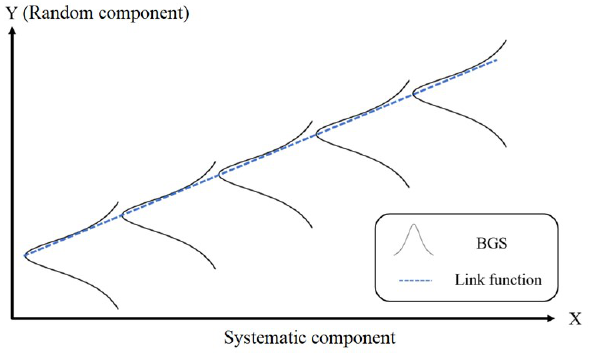
Figure 4. The use of GLM for BFS